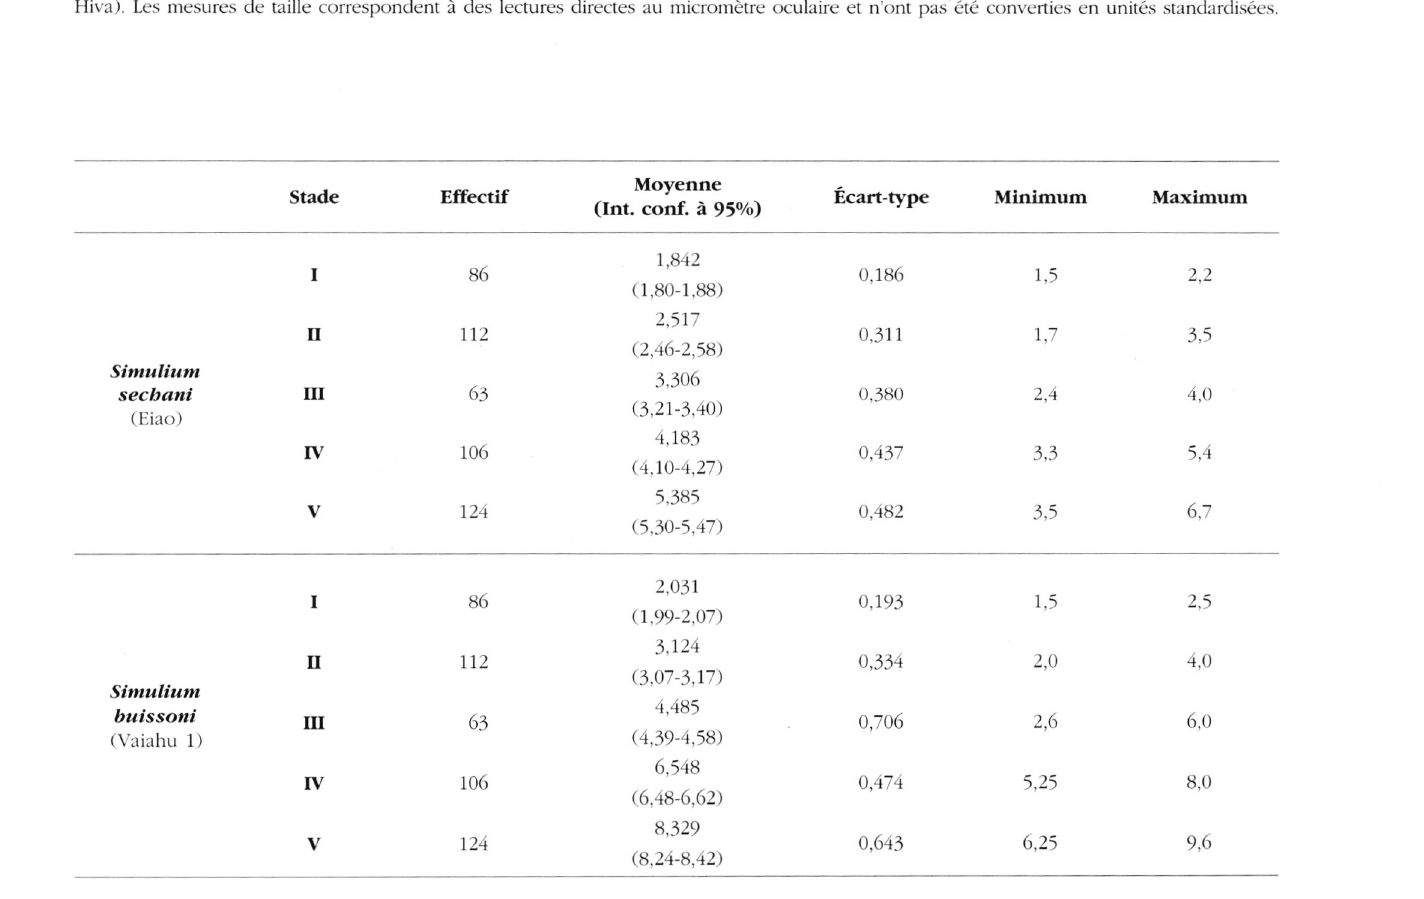
Tableau III. - Caractéristiques du paramètre "b" des cinq premiers stades de S. sechani (Vaituha : Eiao) et de S. buissoni (Vaiahu 1 : Nuku-Hiva). Les mesures de taille correspondent à des lectures directes au micromètre oculaire et n'ont pas été converties en unités